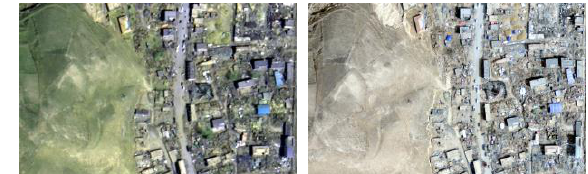
Figure 1 Research experimentation area (Quickbird image of Jiegu Town after the Yushu earthquake; UAV image of Jiegu Town after the Yushu earthquake)